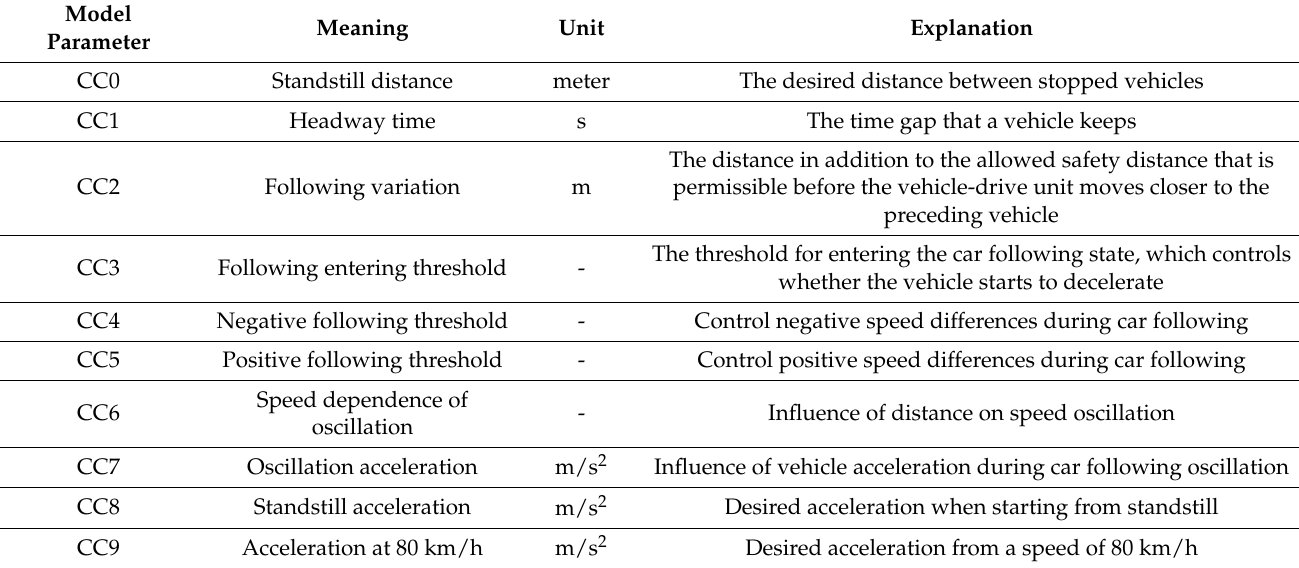
Table 1. Parameters of the Wiedemann 99